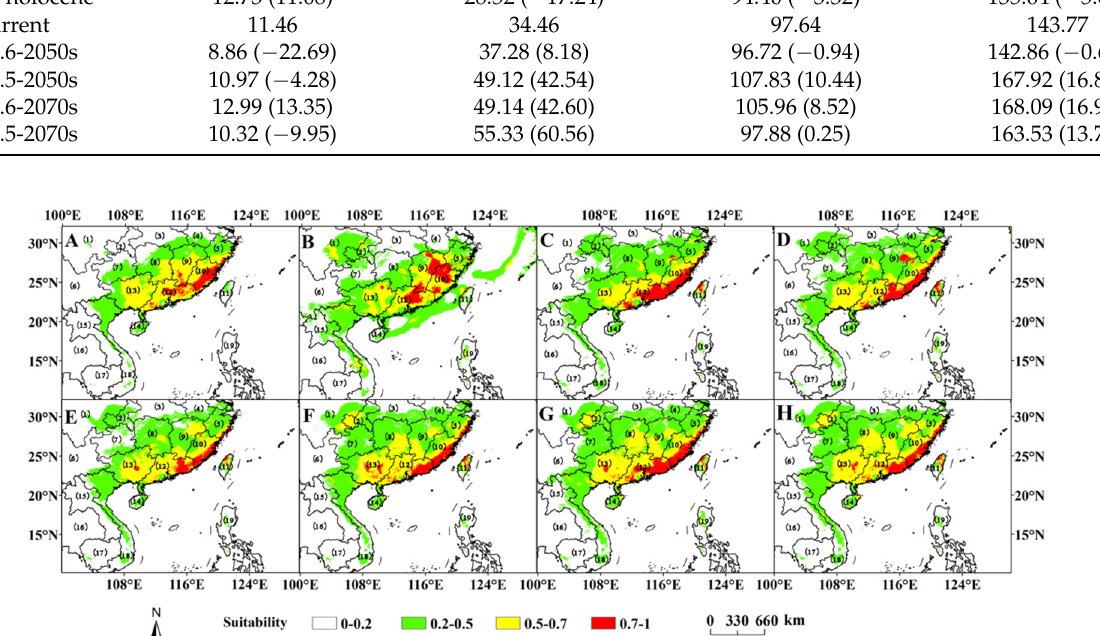
Figure 4. Predicted suitable distribution habitats of G. pensilis based on the MaxEnt model. ( A ) the last interglacial (LIG), ( B ) the last glacial maximum (LGM), ( C ) middle Holocene (MH), ( D ) Current and ( E ) Representative concentration pathway (RCP) 2.6–2050s, ( F ) RCP8.5–2050s, ( G ) RCP2.6– 2070s and ( H ) RCP8.5–2070s; (1) Sichuan; (2) Chongqing; (3) Hubei; (4) Anhui; (5) Zhejiang; (6) Yun-